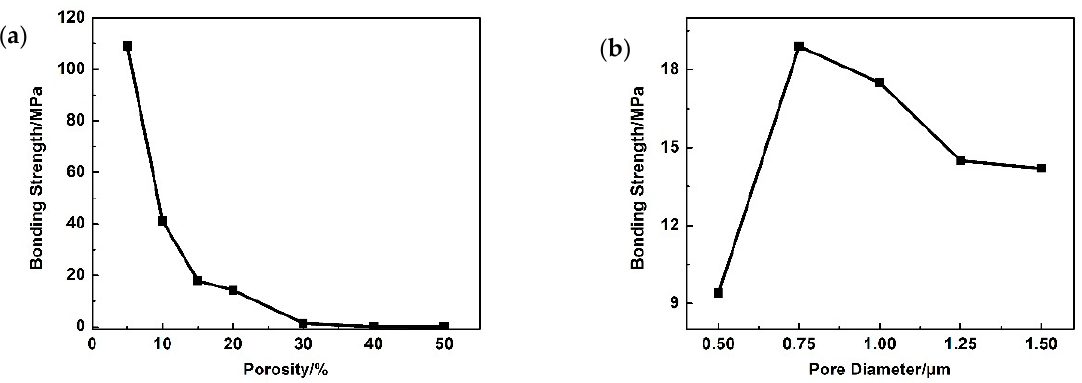
Figure 11. Plot of bonding strength versus porosity and pore diameter: ( a ) 1.5 µ m pore diameter, ( b ) 20% porosity.